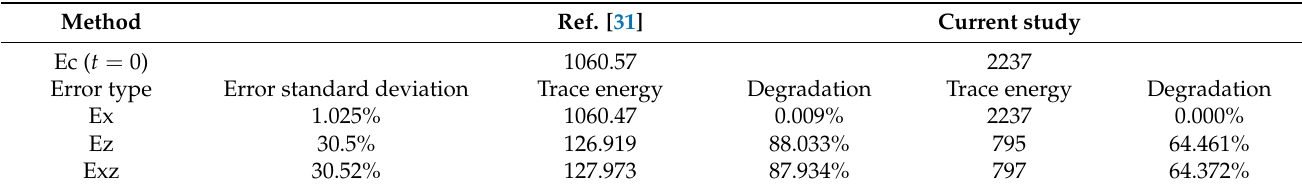
Table 5. Comparison of results of this study to those of